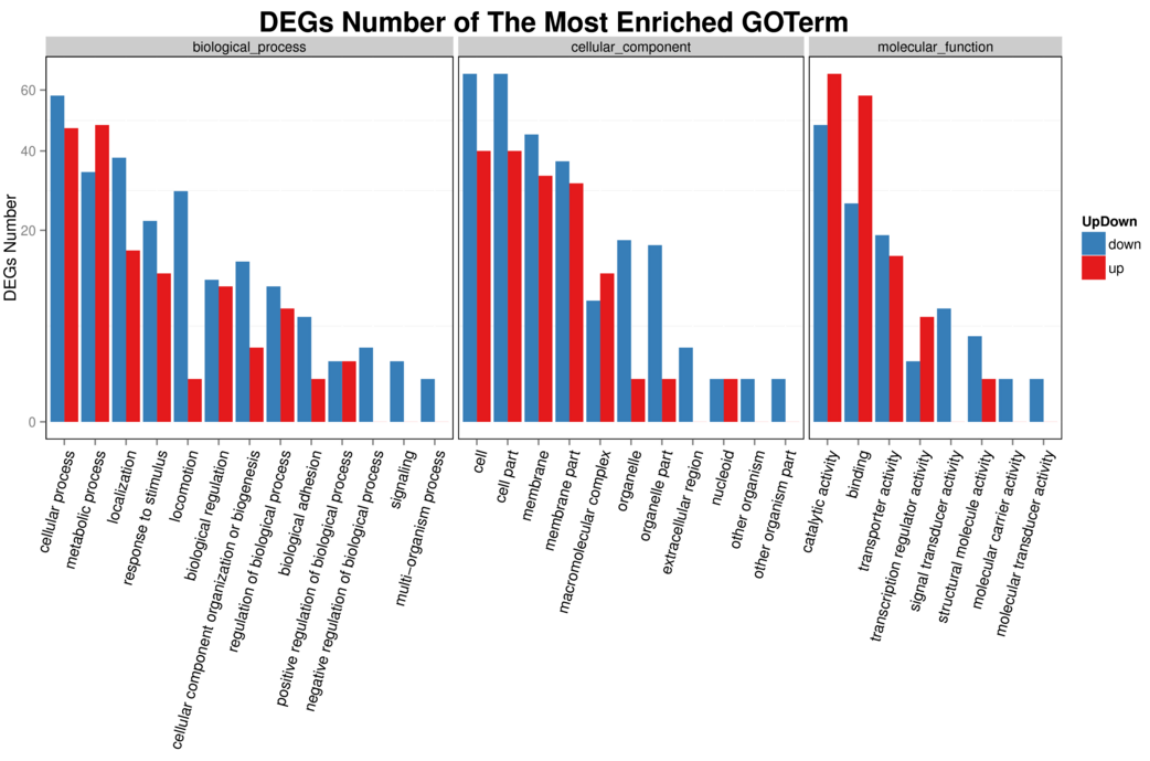
Figure 5. DEG GO classification analysis of wild-type AE81 and mutant AE81 ∆ ygeK strains. DEGs were mainly enriched in biological process, cell composition, and molecular function. Downregulated genes indicated in blue bars; upregulated genes indicated in red bars.